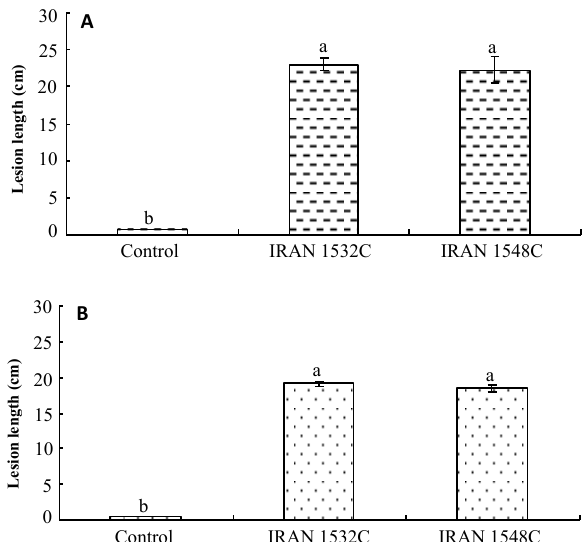
Figure 2. Mean lesion lengths (cm) on apple plants inocu- lated with Diplodia bulgarica under A) field and B) green - house conditions based on Duncan's test. Different let - ters show significant difference at P = 0.01. Bars represent standard errors of means (n =